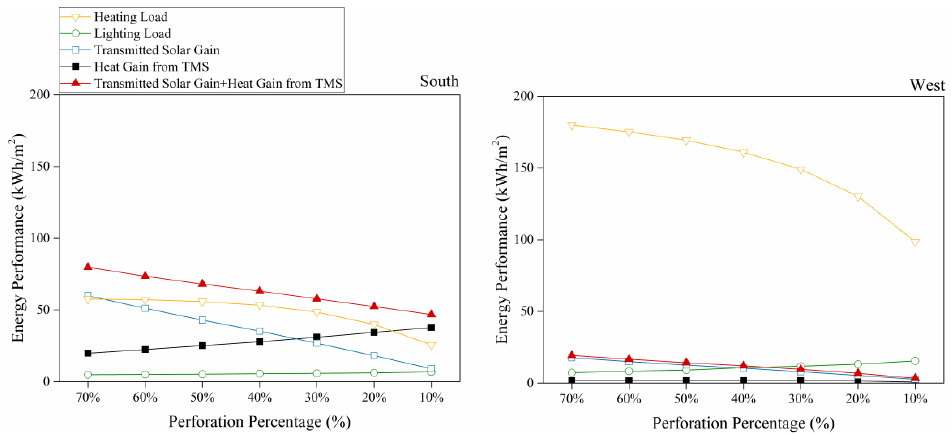
Figure 4. Winter energy performance of different perforated percentages in Group 1.